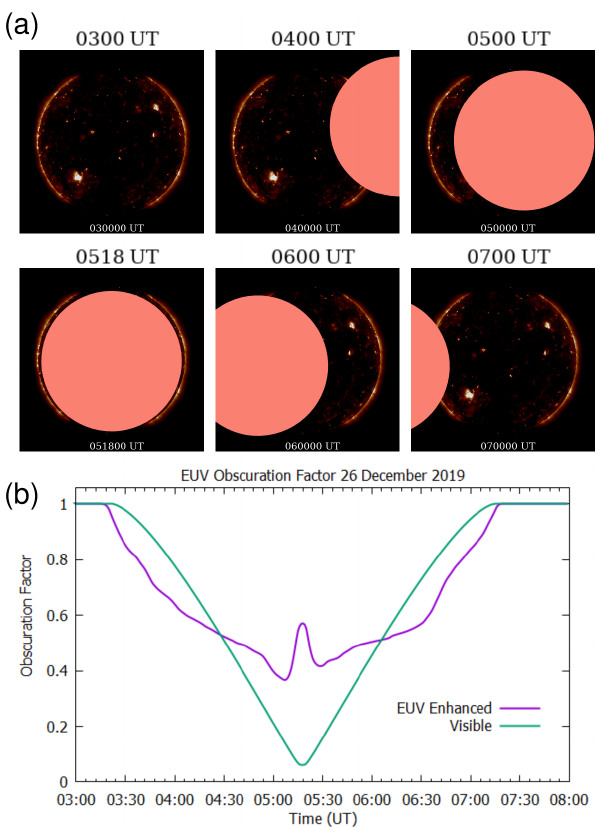
Figure 4. (a) Sample sequence of digitally masked 193Å (19.3nm) solar AIA images on 26 December 2019 to estimate the level of solar obscuration at a given point on the Earth’s surface during the course of the solar eclipse. (b) Time series variation of the obscura- tion of solar irradiance at various wavelengths during the 26 Decem- ber 2019 annular solar eclipse over Siak, Riau province (1.01 ◦ N, 102.25 ◦ E), calculated using this computational masking method.